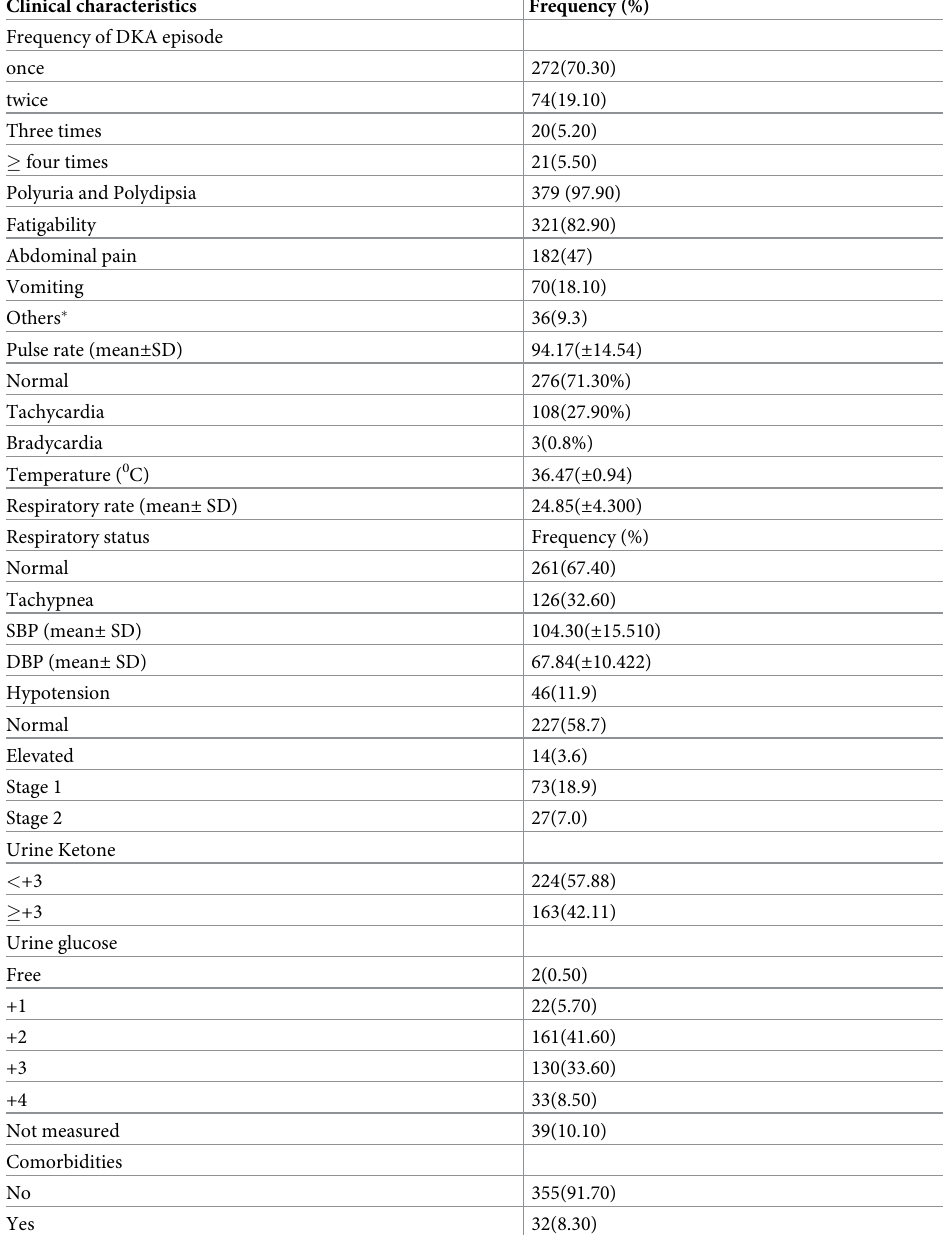
Table 2. Clinical characteristics of DKA patients admitted at DTGH from August 2010 to May 31, 2018(n = 387). Clinical